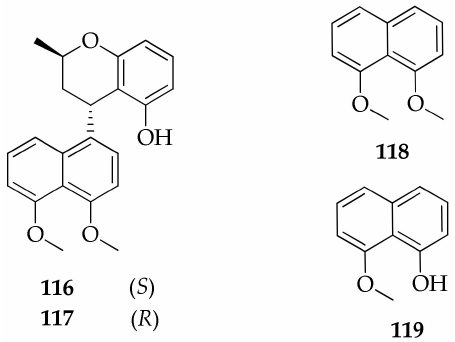
Figure 20. Structures of naphthalene